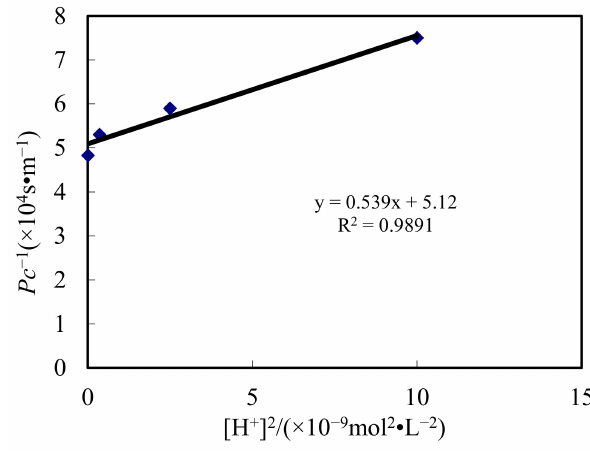
Figure 12. Fitting of test results and theoretical